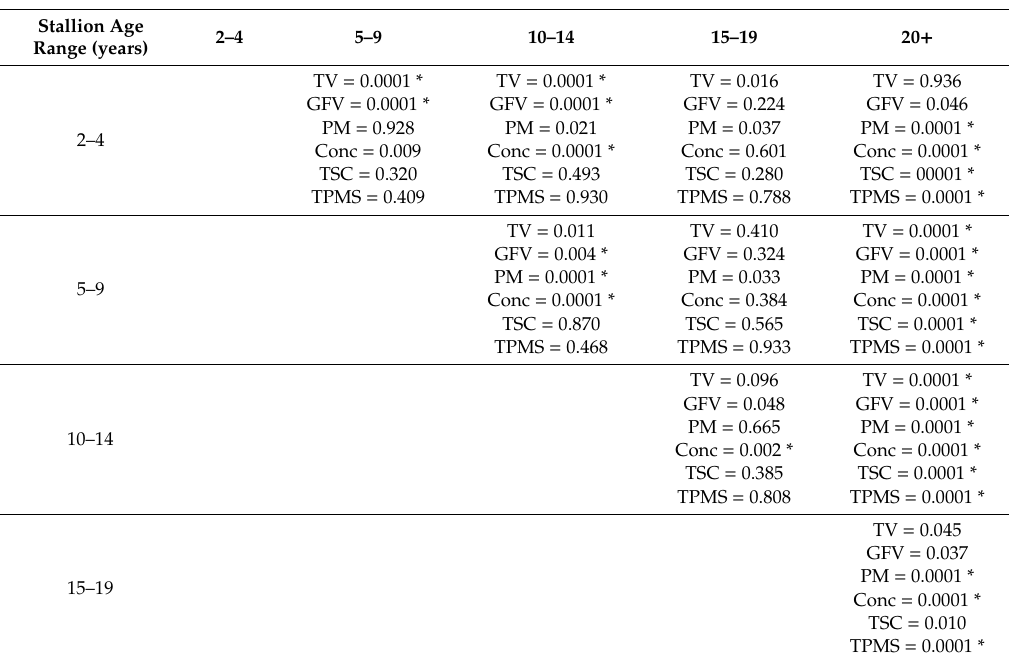
Table 2. Results (probability values) of pairwise comparisons to identify where di ff erences in semen characteristics occur within stallion age